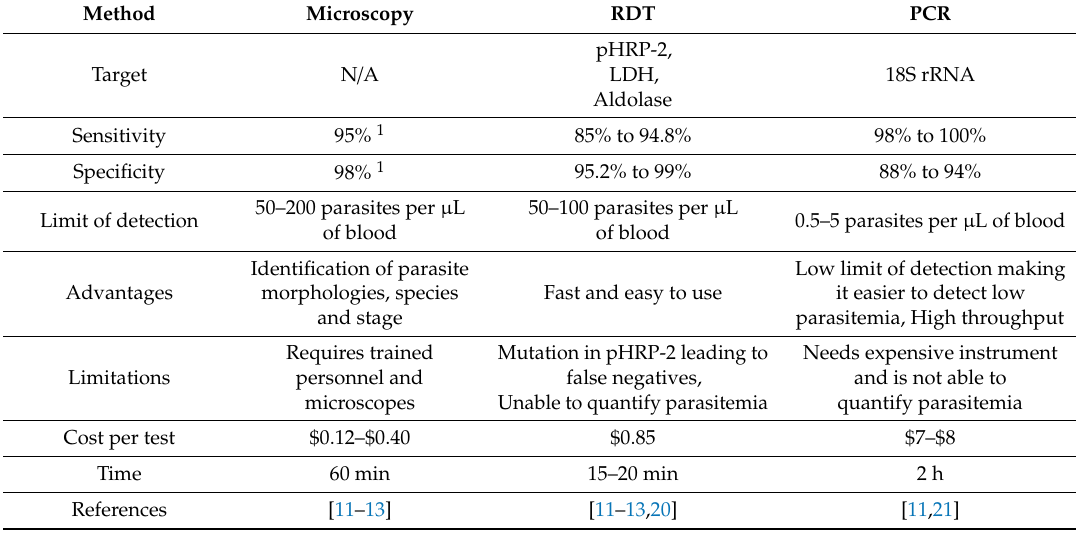
Table 1. Currently used malaria diagnostic methods. For all methods except microscopy, sensitivity and specificity are compared to